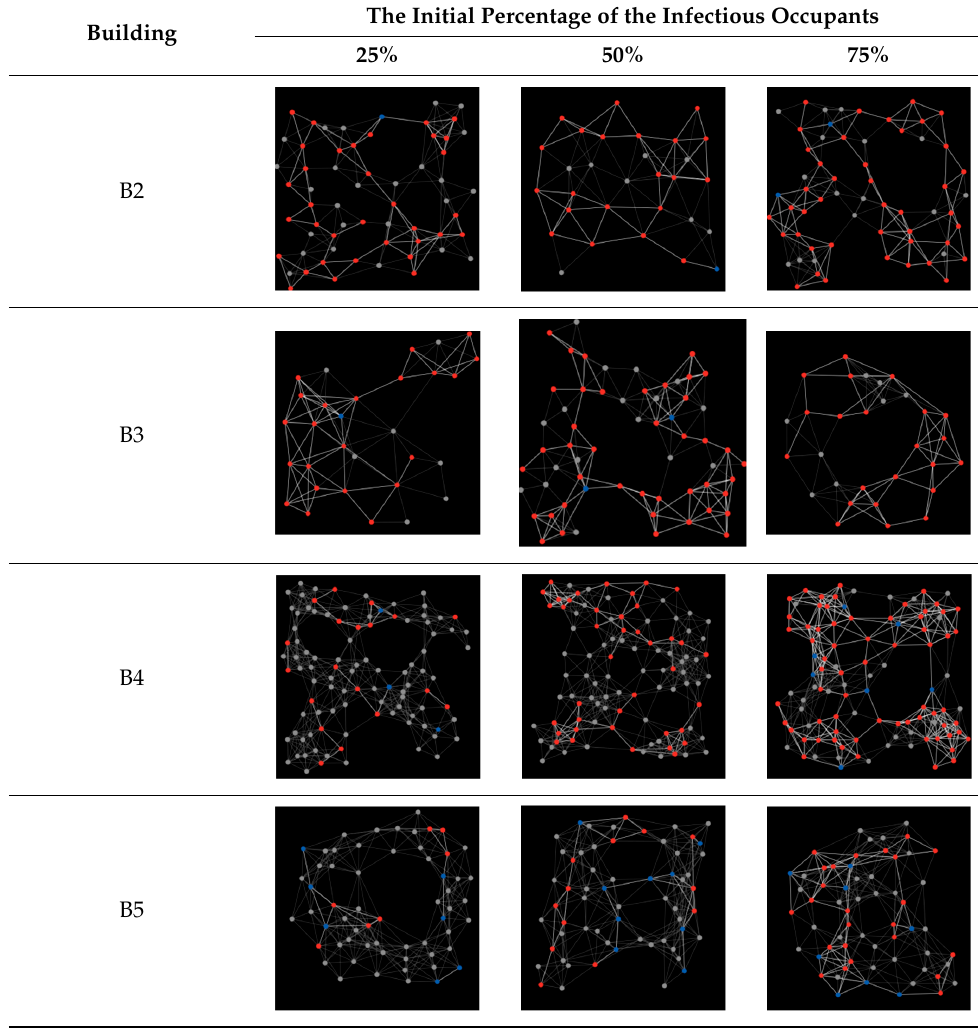
The red dots—the infected occupants; the gray dots—the susceptible occupants; the blue